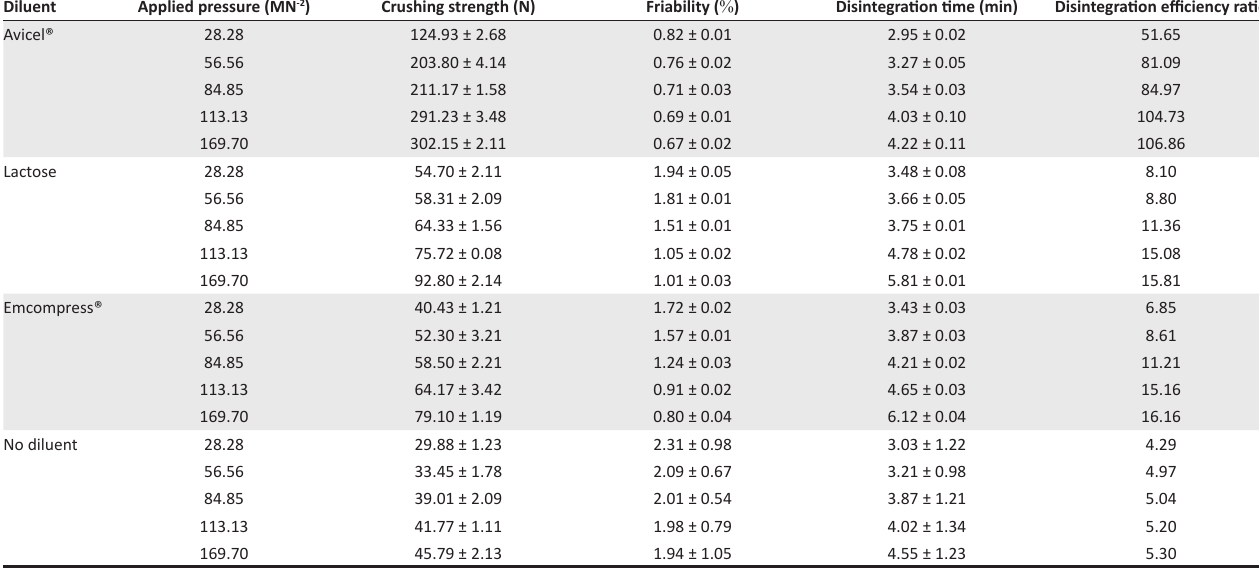
TABLE 3: Properties of Ficus exasperata herbal tablets prepared using various diluents at the drug–diluent ratio of 1:4 (mean ± SD; n † ). Diluent Applied pressure (MN -2 )